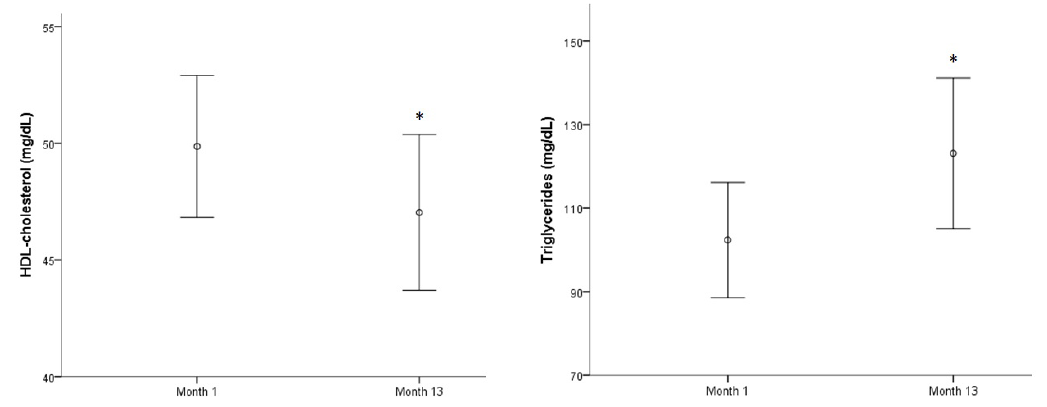
Figure 3. HDL-cholesterol and triglycerides evolution along a year.